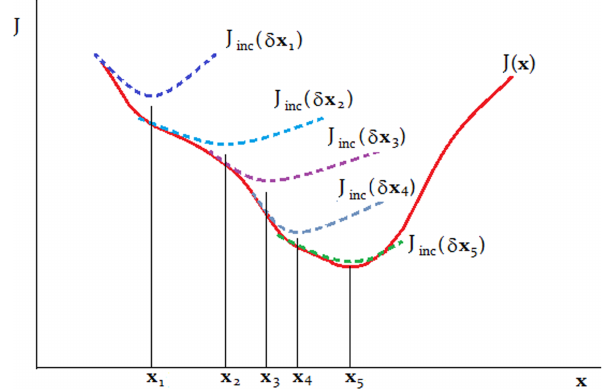
Fig. 6. The outer loop process. The x-axis represents the value of the control vector and the y-axis is the misfit cost (cost function). The red curve represents the non-quadratic true value of the cost function, while the dotted curves represent successive iterations of the outer loop, each with a new estimate of the Jacobian of H in the vicinity of the previous